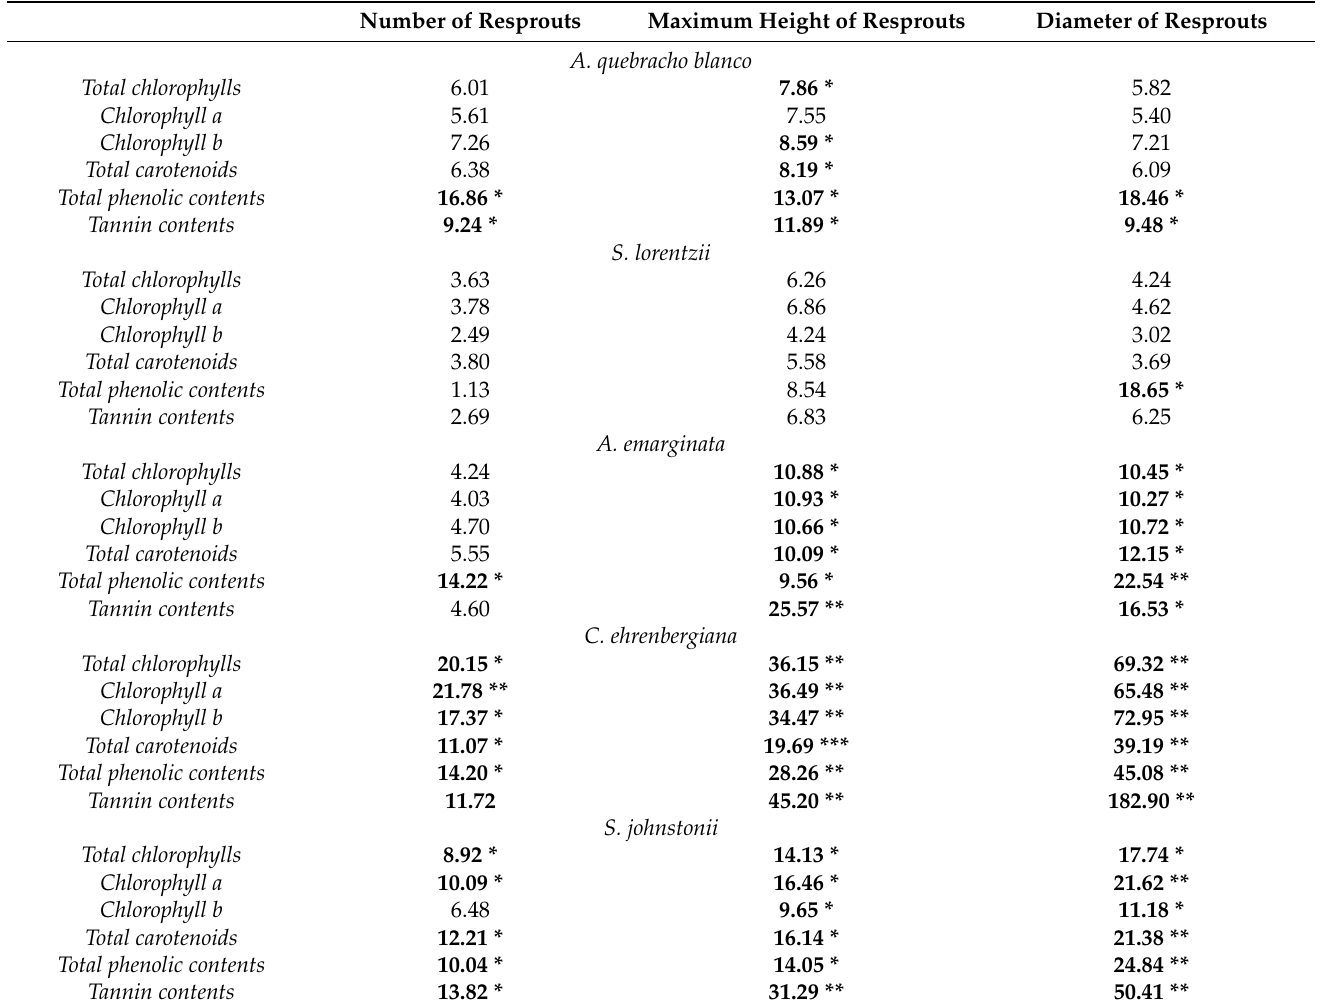
Table 6. Effects of photosynthetic compounds and secondary metabolites over number of resprouts, maximum height of resprouts, diameter of resprouts in five native woody species from the Chaco Region. Values indicate the F-values and stars indicate the significance level. Significance levels: *** <0.001; ** <0.01; * <0.05; <0.1.